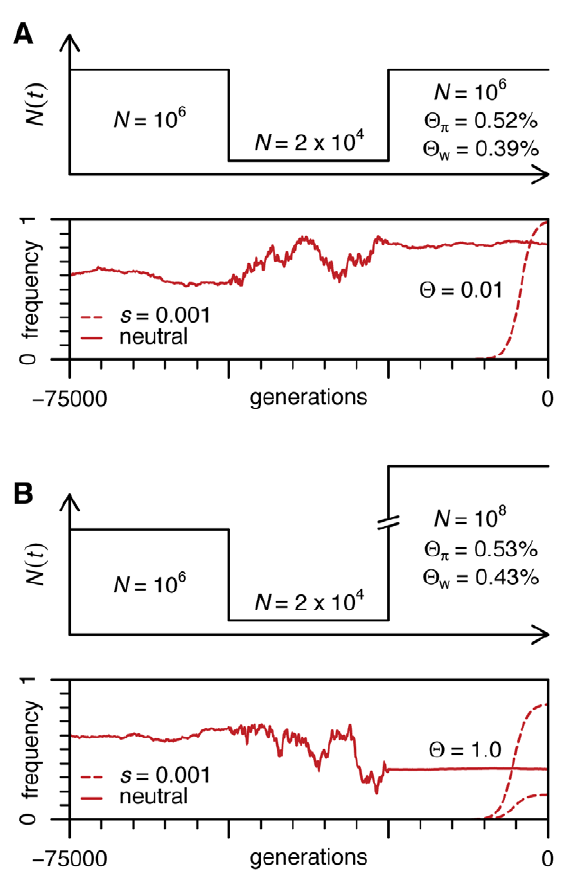
Figure 4. Population dynamics of neutral and adaptive alleles in a population with a bottleneck. (A) The population history similar to that inferred by Thornton and Andolfatto for D. melanogaster [18]. Values of H p and Watterson’s H w were obtained from coalescent simulations with 100 sampled genomes. (B) Same scenario as (A) except for the current population size is changed to 10 8